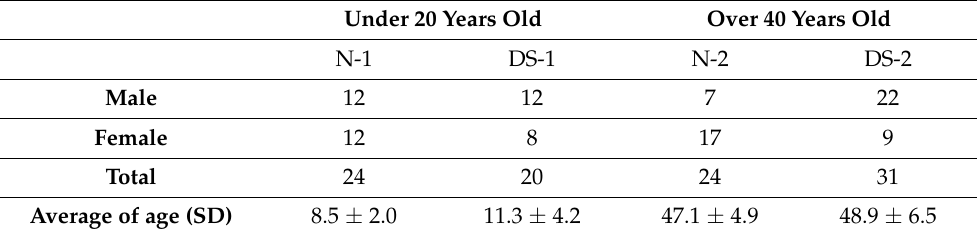
Table 1. The gender composition and mean ages of the study group.